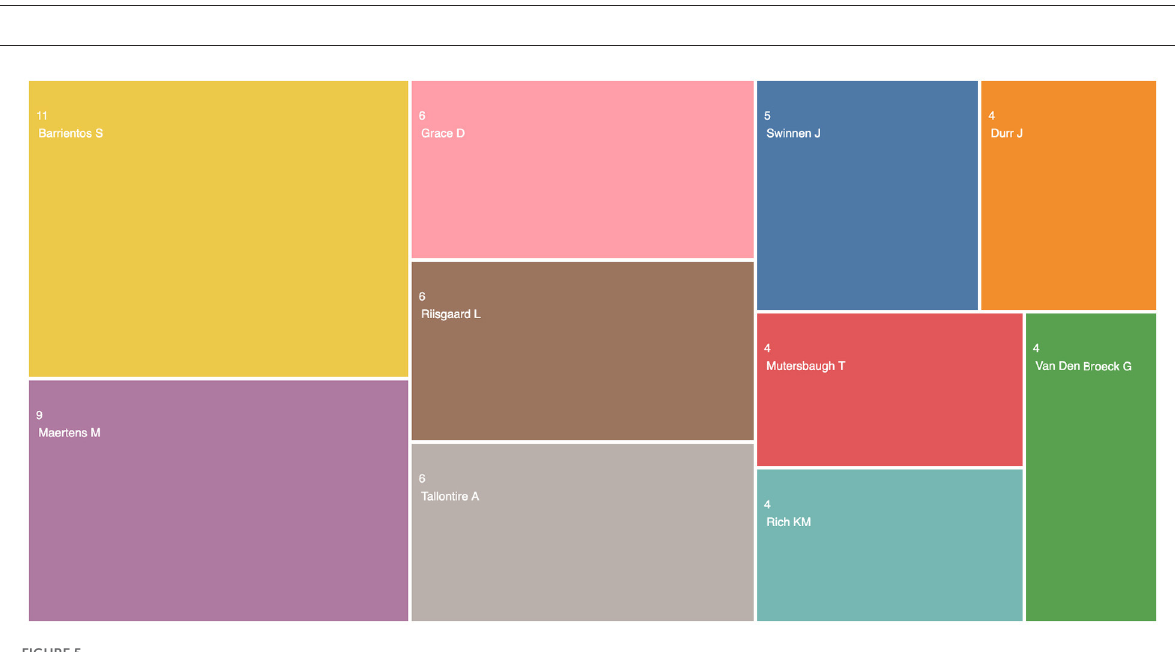
analysis of how agri-food value chain agents coordinate labor issues within the chain. Standards are the main mechanism of governance used by the agents, principally private standards— including certification (e.g., fair trade)—to regulate several issues, whether they are directly or indirectly linked to labor,